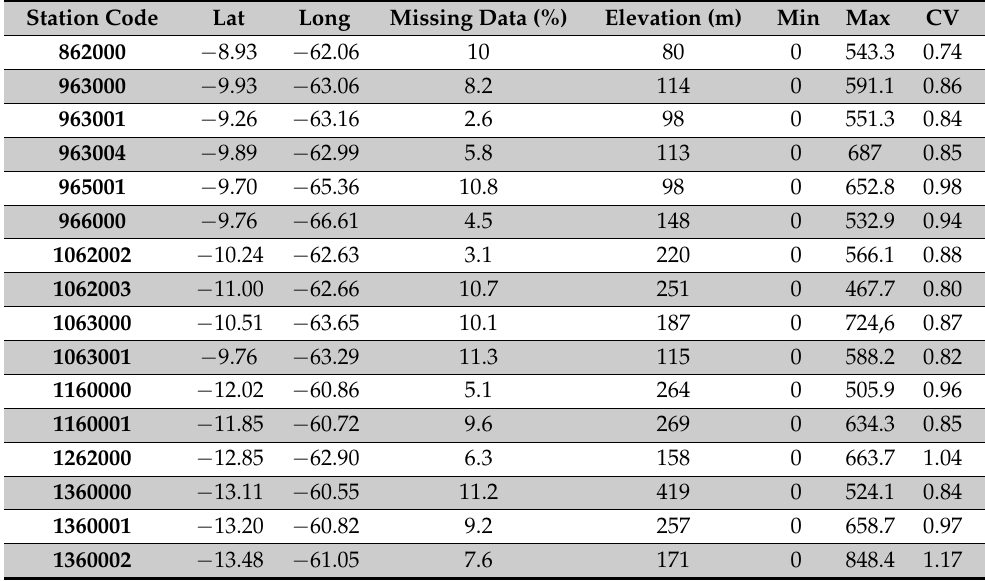
Table 1. Information from rain gauges in Rond ô nia regarding their identification code, latitude, longitude, percentage of faults and elevation in